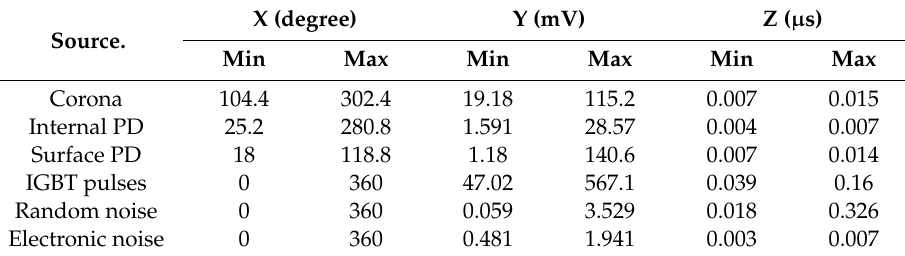
Table 1. Containers parameters for each PD source.